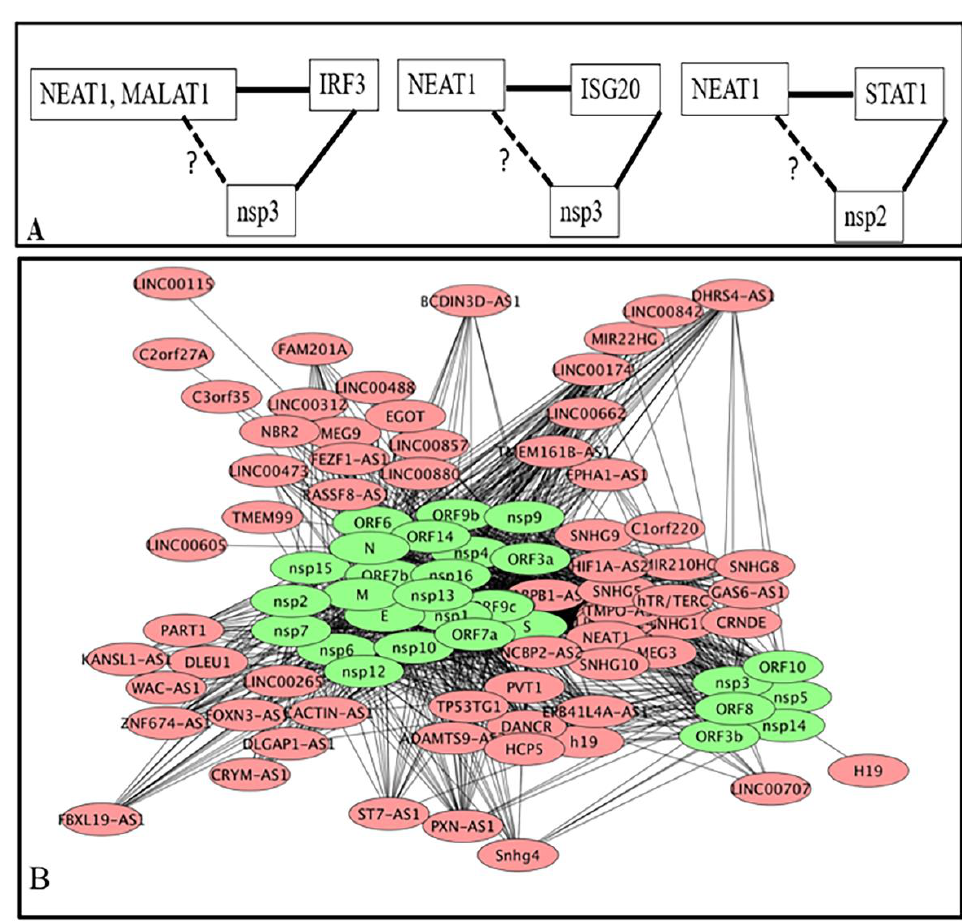
Figure 4. Common proteins among host interacting partners of SARS-CoV-2 coded proteins and targets of deregulated lncRNA ( A ), ( B ) represents the common proteins among genes/proteins iden- tified to modulate SARS-CoV-2 infection and targets of deregulated lncRNA. ( C ) represents com- mon PCGs altered in SARS-CoV-2 infected cells or in tissues from COVID-19 and targets of dereg- ulated lncRNA.